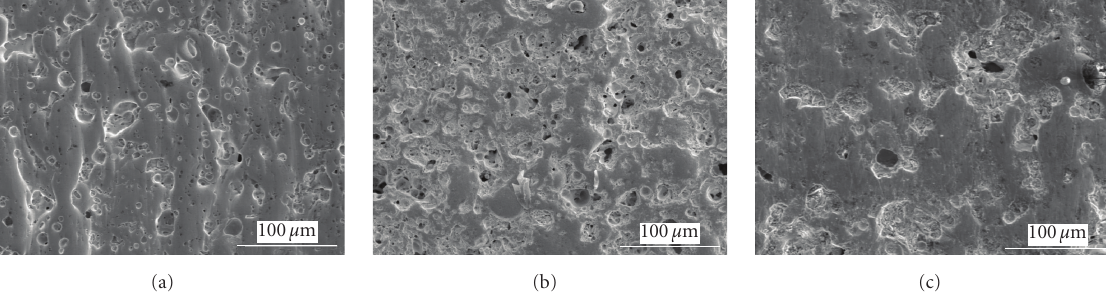
Figure 12: (a) WC-17Co coating 100–350 after SAR test in alumina powder P1. (b) WC-17Co coating 100–350 after SAR test in garnet powder P3. (c) WC-17Co coating 100–350 after DSRW test.